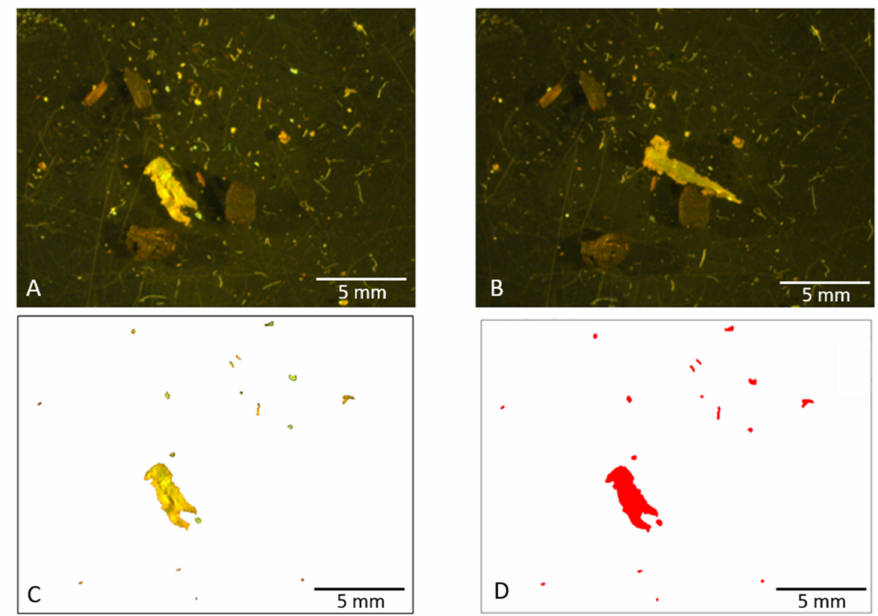
Figure 1. Example of the picture analysis procedure with a compost sample. ( A ) Initial picture of the material gathered on the glass slide after filtration. ( B ) The material after heating. ( C ) The visual identified particles. ( D ) Threshold mask for analysing particles in